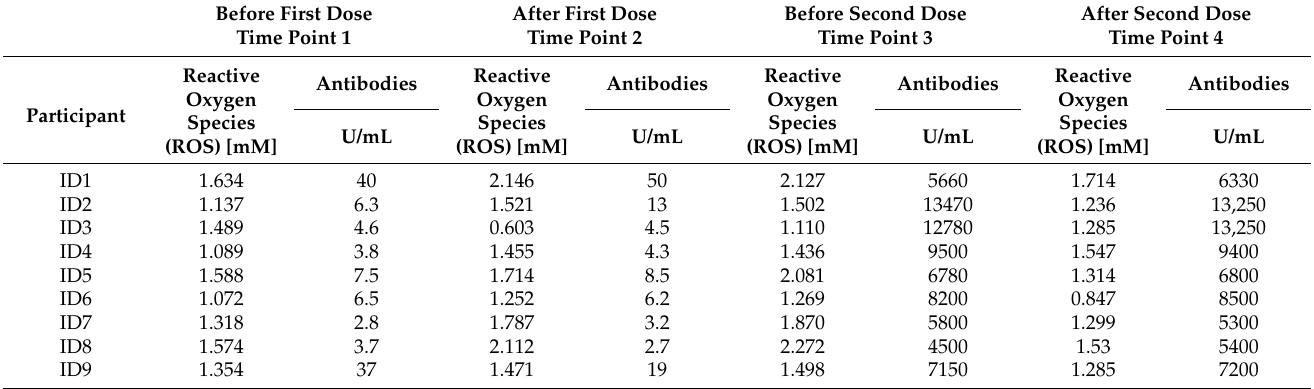
Table 2. Reactive oxygen species (ROS) levels (mM) and antibody levels (U/mL) of selected partici- pants ( n = 20). Time point 1: participants before the first dose of mRNA vaccine against COVID-19; time point 2: participants after the first dose; time point 3: participants before the second dose; and time point 4: participants after the second dose. Data are the averages ± SDs of the four measure- ments. Significant differences between time points 3 (before second dose) and 4 (after second dose) are represented as p <